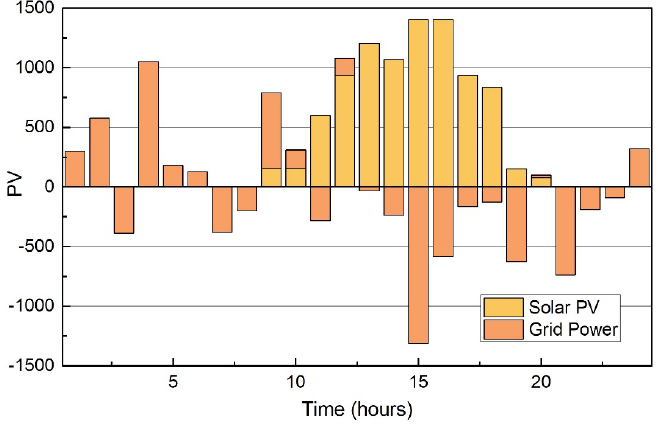
Figure 6. Case (2): Energy exchange with solar PV and the grid.